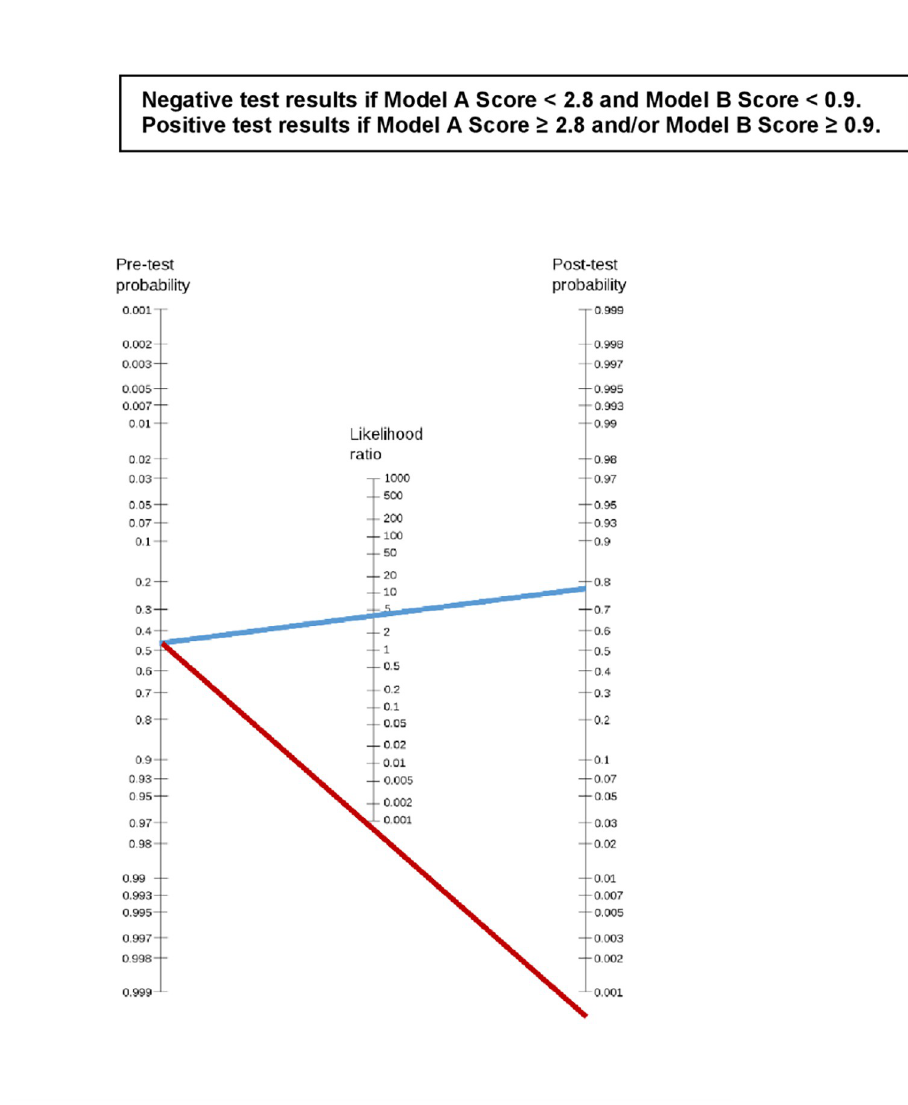
Fig 1. Pre-test and post-test probabilities of the risk scoring model. Calculation of post-test probabilities using likelihood ratio. Pre-test probability = p = (TP+FN)/(TP +FP + FN +TN) = 0.47. Pre-test odd = p/1-p = 0.47/ 0.53 = 0.89. Post-test odds = pre-test odds x likelihood ratio. Post-test odds = o = 0.89 x 3.7 = 3.3. Post-test probability = o/(1 +o) = 3.3/4.3 = 0.77.